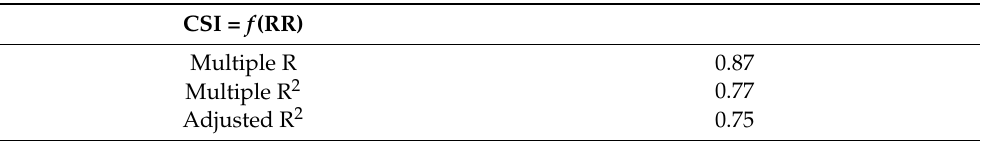
Table 7. CSI: Cliff Susceptibility Index. Multiple R: Multiple correlation coefficient. Multiple R 2 : Coefficient of multiple determination. Adjusted R 2 : Coefficient of determination adjusted by the number of independent